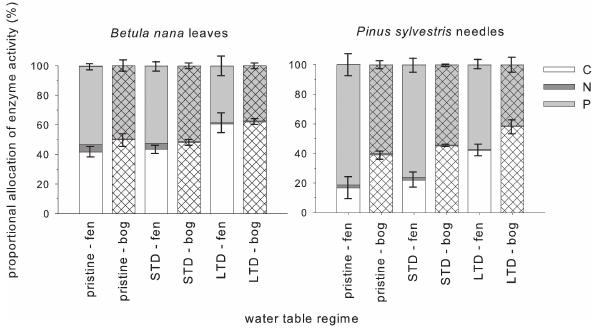
Fig. 4. Direct effects of water table (WT) drawdown and site nu- trient regime on enzyme activity allocation. Data are presented as averages per litter type and plot (nutrient and WT regime), the er- ror bars represent standard error of mean (s.e.). For N-acquiring enzymes s.e. was less than 0.5. C, C-acquiring enzymes; N, N- acquiring enzymes; P, P-acquiring enzymes. Site WT regimes: STD, short-term WT drawdown; LTD, long-term WT drawdown. Patterned bar fill marks the bog